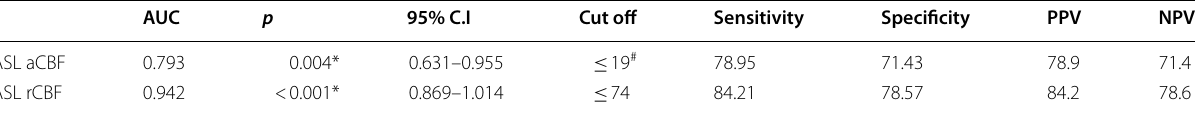
Table 4 Validity (AUC, sensitivity, specificity) of ASL aCBF and rCBF to assess the expected stroke outcome (favorable or poor